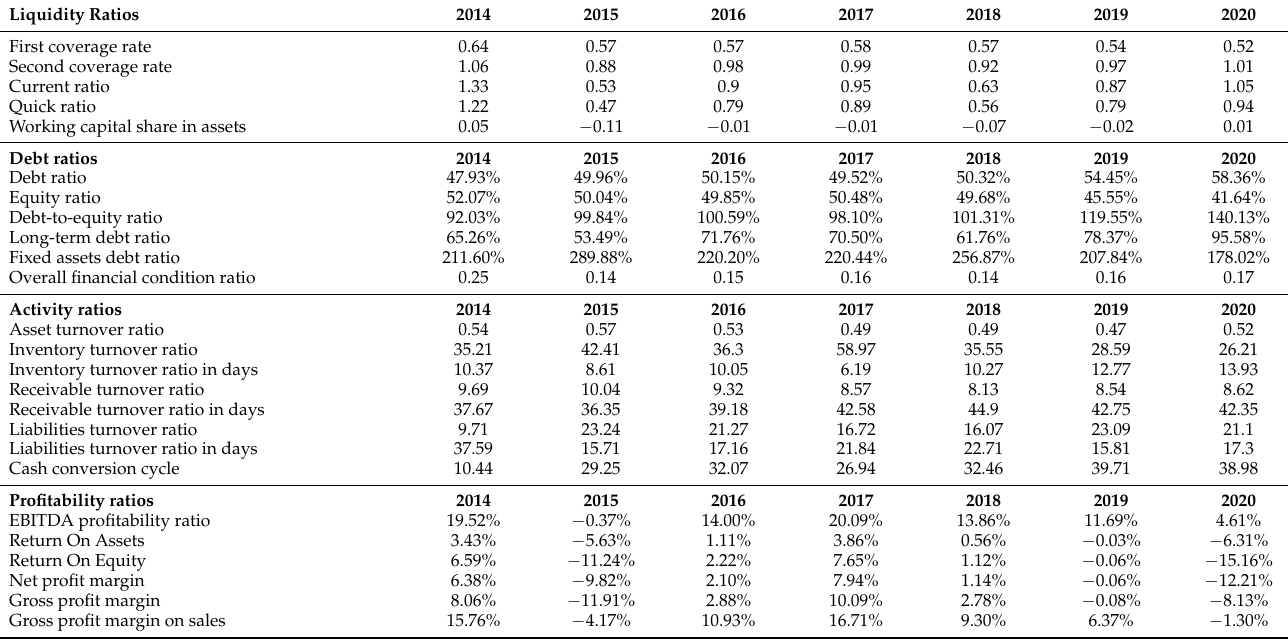
Table 8 presents selected financial indicators for the Tauron Group’s generation business. Table 8. Financial ratios of Tauron capital group in the years